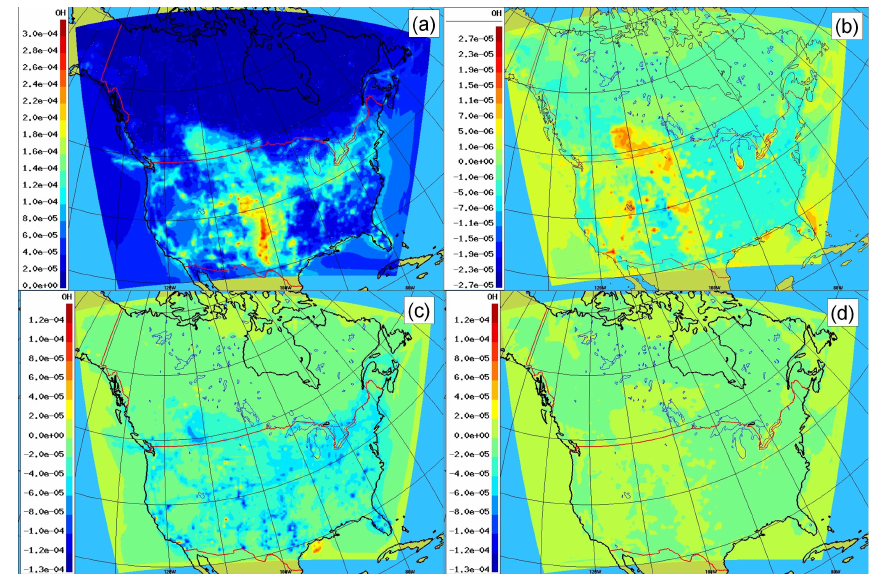
Fig. 10. As in Fig. 7, daily average OH (units